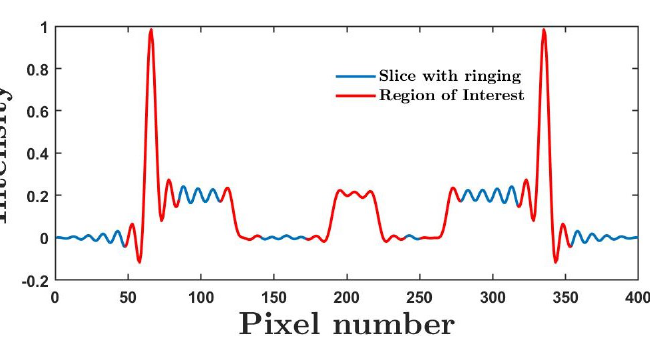
Figure 6. 1D slice of the Shepp–Logan phantom with ringing. The RoI is in red. The excluded regions are in